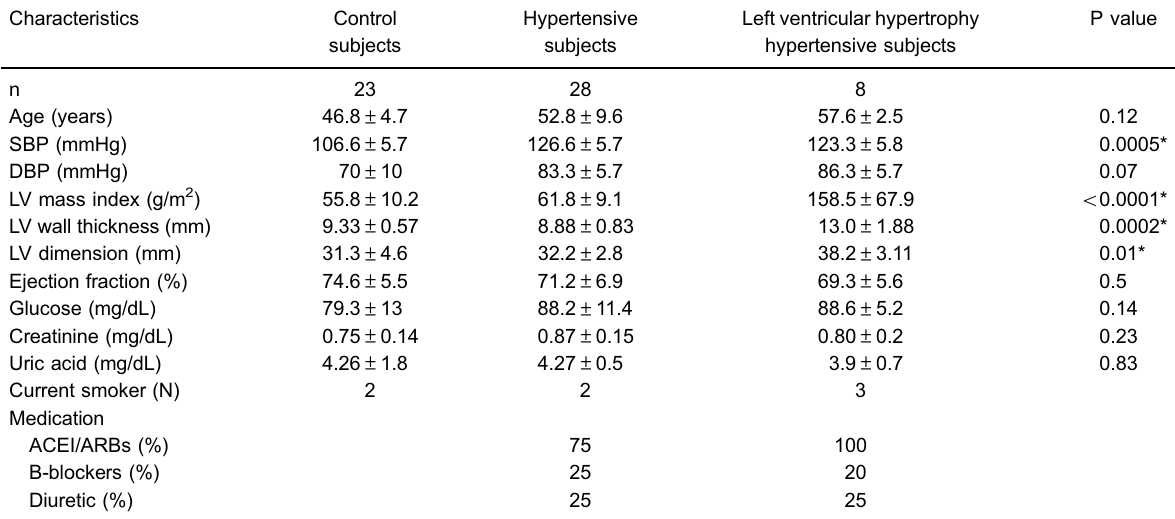
Table 1. Clinical characteristics of the patients.